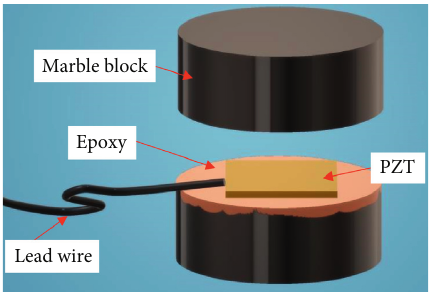
Figure 1: Structure of the SA.